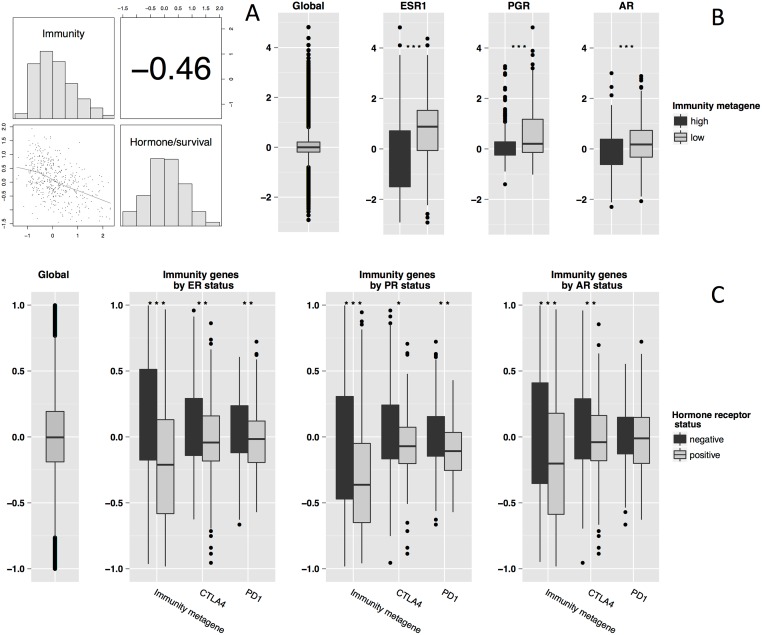
Association between Hormone genes expression and Immunity genes expression.A Correlation of Immunity metagene and Hormone/Survival metagene expression (training set). Pearson’s correlation coefficient is -0.46 (95% CI [-52.7–38.0], p<10−16). B Boxplots of global gene expression and ESR1, PGR and AR expression by Immunity metagene status, “low” versus “high” in the training set (A). P-values for ANOVA are p = 10−16, p = 10−6 and p = 0.0002, respectively. C Boxplots of Immunity metagene and immune gene (CTLA4 and PD1) expression levels by ER, PR and AR status in the training set (A). The p values for ANOVA were p<10−16, p = 0.002 and p = 0.008 for the Immunity metagene, CTLA4 and PD1 by ER status, respectively; p = 0.0001, p = 0.05 and p = 0.001 by PR status, respectively; and p<10−6,
p = 0.006 and p = 0.23 by AR status, respectively. The statistical significance (p-value) of the difference between gene expression values is indicated by black stars (p-value ≤ 0.05: *; p-value≤ 0.01: **; p-value≤ 0.001: ***).